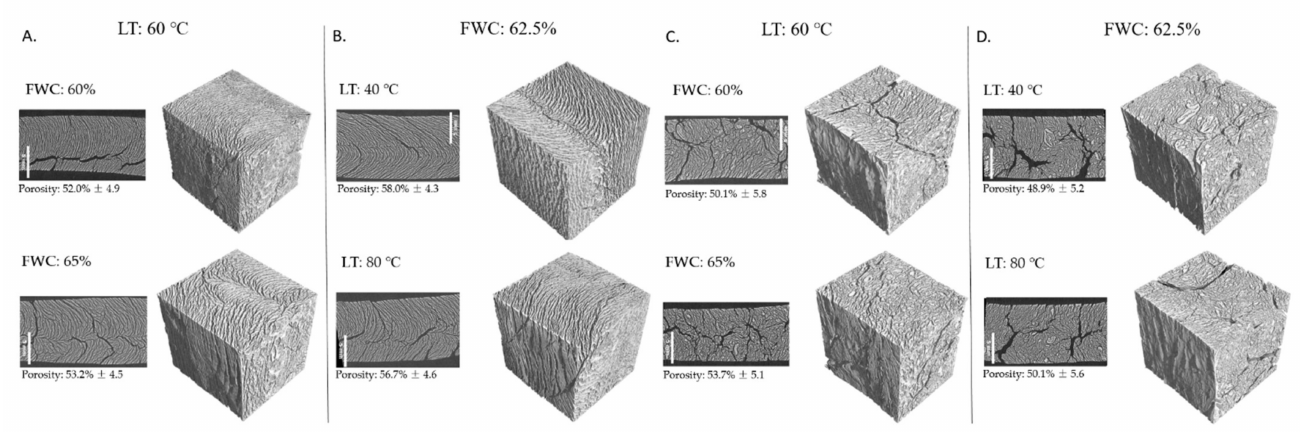
Figure 4. Micro tomography images and porosity values of the samples containing 30% ( A , B ) and 70% ( C , D ) faba bean protein isolate extruded at various long cooling die temperatures (LT) and feed water contents